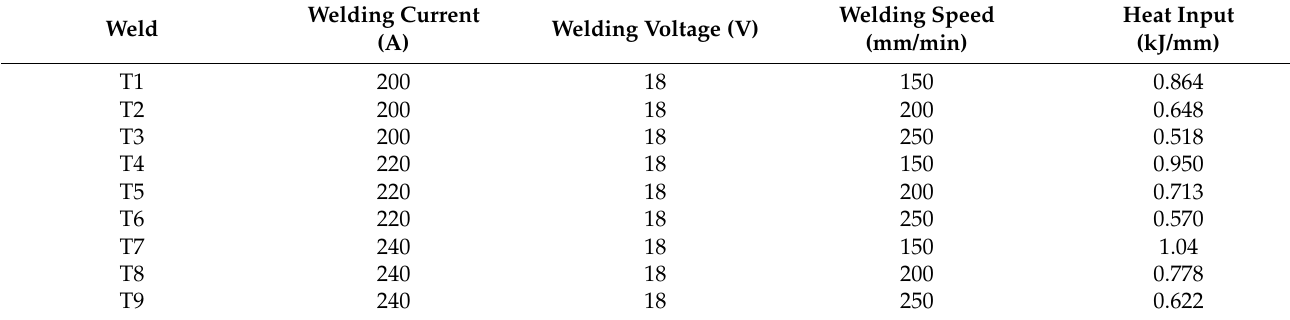
Table 3. Parameters of TIG welding.